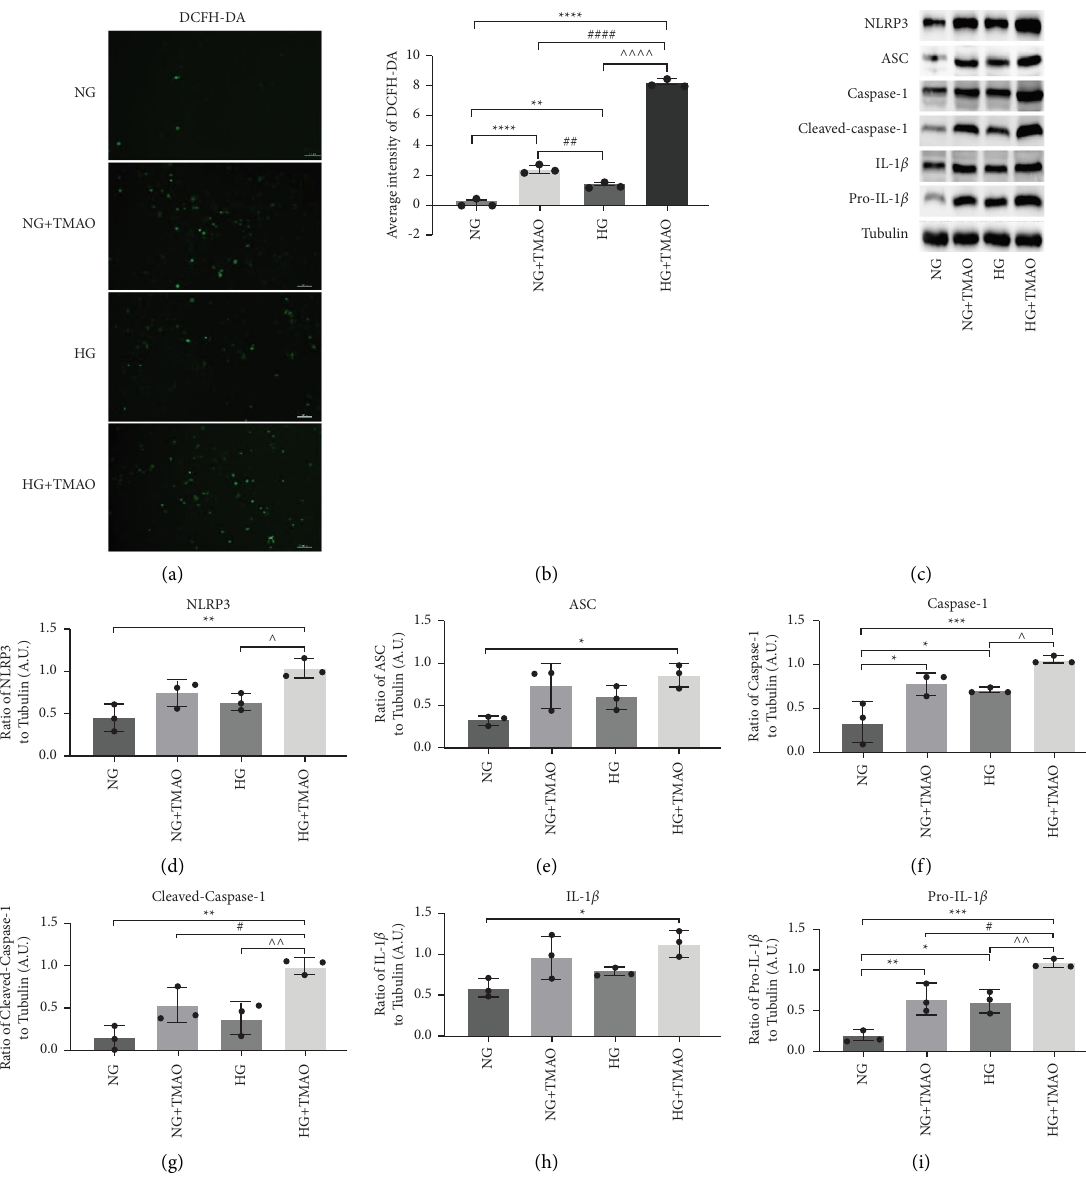
Figure 5: TMAO enhances high-glucose-induced ROS and NLRP3 infammasome signaling activation. Reactive oxygen species (ROS) levels in HRMECs treated for 72h, detected using DCFH-DA. Green fuorescence represents the positive ROS expression. (a) Scale, 50 μ m. Average intensity of green fuorescence. (b) After treatment with NG, NG+TMAO, HG, HG+TMAO for 72h, NLRP3 infammasome proteins were measured using western blot. (c) NLRP3. (d) ASC. (e) Caspase-1. (f) Cleaved-caspase-1. (g) IL-1. (h) Pro-IL-1 β . (i) Expression ratios compared to tubulin. ∗ P < 0 . 05 vs. NG; ^ P < 0 . 05 vs. HG; # P < 0 . 05 vs. NG+TMAO, n �